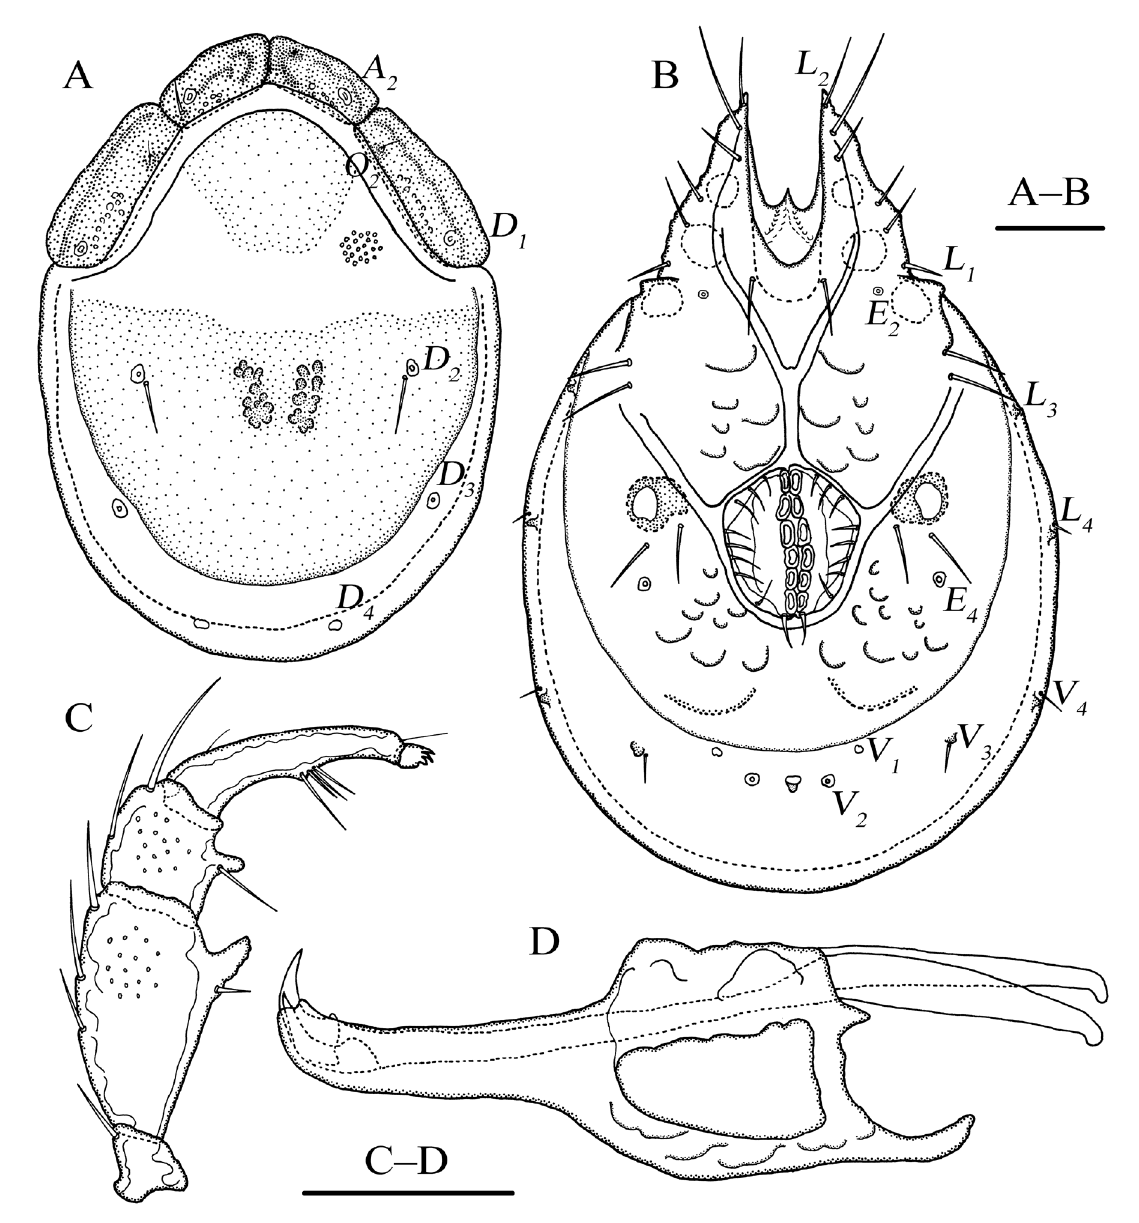
Fig. 7. Torrenticola spinextension Gu & Guo sp. nov., ♀, paratype (FJ-TO-20180805). A . Dorsal view. B . Ventral view. C . Palp, lateral view. D . Infracapitulum and chelicera. Scale bars = 100